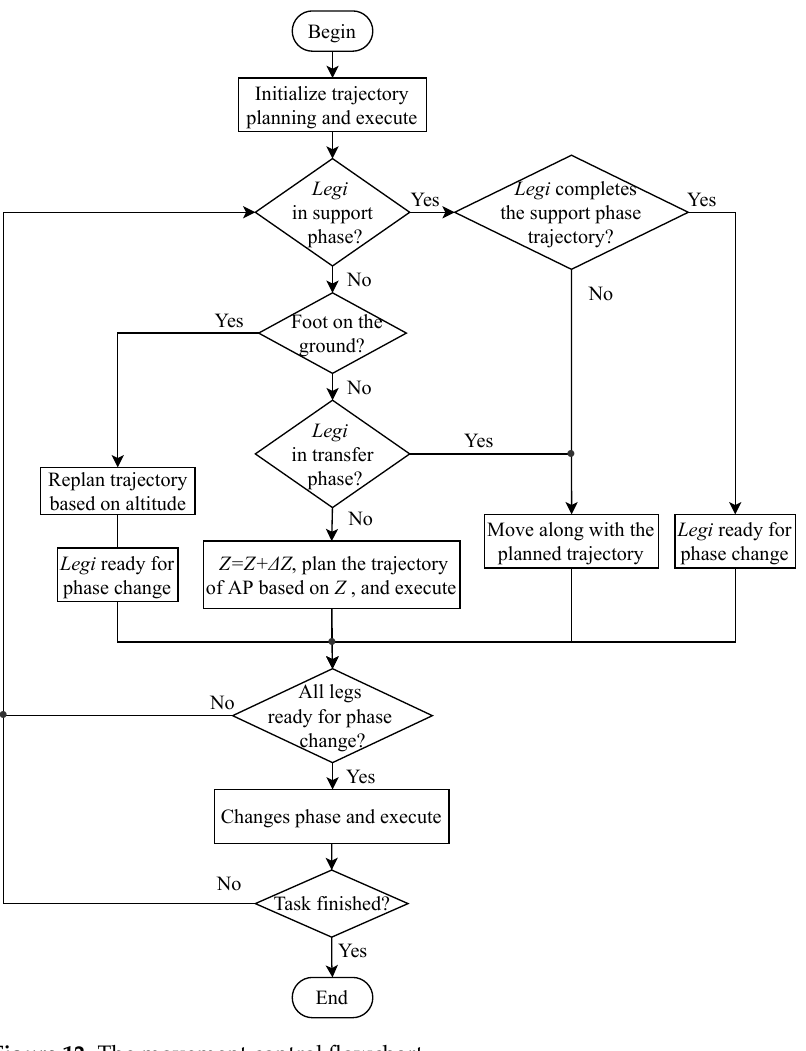
Figure 12. The movement control